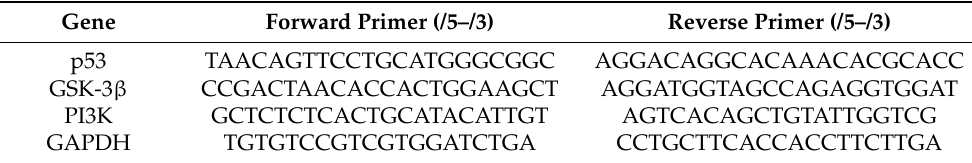
Table 5. Primer sequences used for